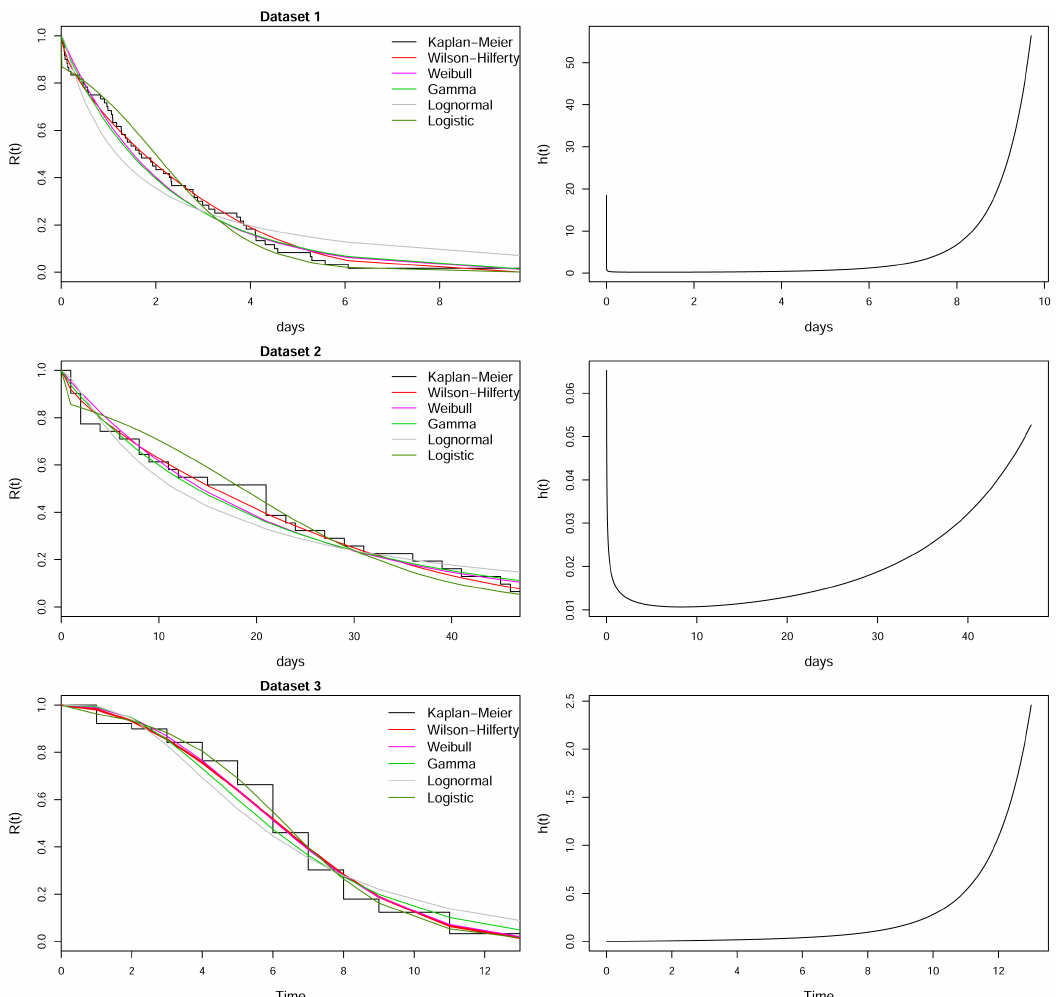
Figure 5 - Reliability function adjusted by different distributions superimposed to the empirical reliability function. Right-hand panel: Estimated hazard